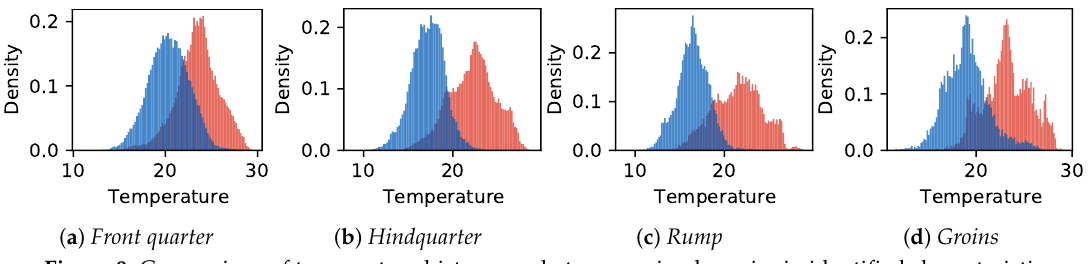
Figure 9. Comparison of temperature histograms between animal species in identified characteristic areas corresponding to selected groups of ROIs: ( a ) GOR 2 Front quarter ; ( b ) GOR 4 Hindquarter ; ( c ) GOR 5 Rump ; ( d ) GOR 9 Groins . Horses are represented in red and donkeys in blue.